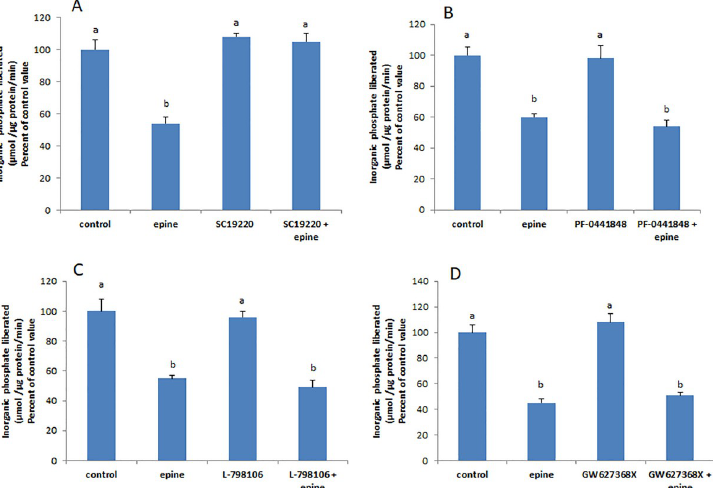
Fig 1. Epinephrine acts via EP1 receptors. The inhibitory effect of epinephrine (0.5mM, 20 min) disappeared in presence of ( A) SC 19220, an EP1 antagonist (100 μ M), but still appeared in presence of antagonists to (B) EP2(PF- 7981106; 1 μ M), (C) EP3 (L-798106; 1 μ M) and ( D) EP4 (GW 627368X; 10 μ M). Values are means ± SEM of at least 3 observations. Bars not sharing a common letter are considered significantly different from each other at P < 0.01.